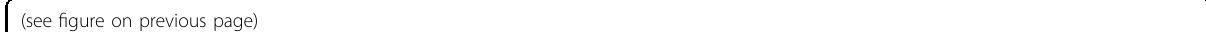
Fig. 5 Single-molecule analyses of the diffusion dynamics and interactions of endogenous EGFR and HER2 in cancer cells. a Live-cell single- molecule imaging and tracking of endogenous (en) EGFR-Halo and HER2-Halo molecules at the plasma membrane of SUM159 cells genome-edited for EGFR-Halo/HER2-mEGFP or HER2-Halo/EGFR-mEGFP (labeled by JFX 650 -HaloTag ligand). Shown are representative single frames and tracking traces of time-lapse series acquired in the cells treated without or with EGF (100 ng/mL) by TIRF microscopy. b MSD- Δ t plots (left two panels) and diffusion coef fi cients (middle panel) of EGFR-Halo tracks ( n = 115, 109, and 110 cells from 4 independent experiments) and HER2-Halo tracks ( n = 117, 119, 120 cells from four independent experiments) from genome-edited SUM159 cells treated with 0, 10, or 100 ng/mL EGF and imaged by TIRF microscopy. The right panel shows fractions of tracks classi fi ed as mobile, con fi ned, or immobile ( n = 4 independent experiments). c SK-BR-3 cells genome-edited for EGFR-Halo or HER-Halo were labeled by JFX 650 -HaloTag ligand, treated with 0, 10, or 100 ng/mL EGF, and imaged by TIRF microscopy. MSD- Δ t plots (left two panels) and diffusion coef fi cients (middle panel) of EGFR-Halo tracks ( n = 150, 156, and 158 cells from 4 independent experiments) or HER-Halo tracks ( n = 152, 149, 153 cells from 4 independent experiments), and fractions of tracks classi fi ed as mobile, con fi ned, or immobile (right panel, n = 4 independent experiments) are shown. d SUM159 cells genome-edited for both EGFR-SNAP and HER2-Halo were labeled by JFX 650 -SNAP-tag ligand and JFX 549 -HaloTag ligand, treated without or with EGF, and then imaged by TIRF microscopy. The representative single frame and tracking traces (co-localized trajectories are highlighted in blue) of the time-lapse series of a cell treated with 100 ng/ mL EGF were shown on the left. Individual 3D trajectories (top) and distances (bottom) between EGFR-SNAP and HER2-Halo as a function of time are shown in the middle panels. The relative fractions of HER2 tracks that interact with EGFR in cells treated with 0, 10, or 100 ng/mL EGF are shown on the right ( n = 73, 77, and 77 cells from 2 independent experiments). e SUM159 cells genome-edited for EGFR-SNAP were transiently expressed with HaloTag-tagged CD86, HER2, HER2-GS, EGFR, and EGFR-GS, labeled by JFX 650 -SNAP-tag ligand and JFX 549 -HaloTag ligand, and then imaged by TIRF microscopy. Shown are the relative fractions of tracks in Halo channels that interact with the SNAP-tagged endogenous EGFR ( n = 36 – 40 cells from 2 independent experiments). Scale bars, 5 μ m. Error bars show means ± SD except for the MSD- Δ t plots (means ± 95% con fi dence